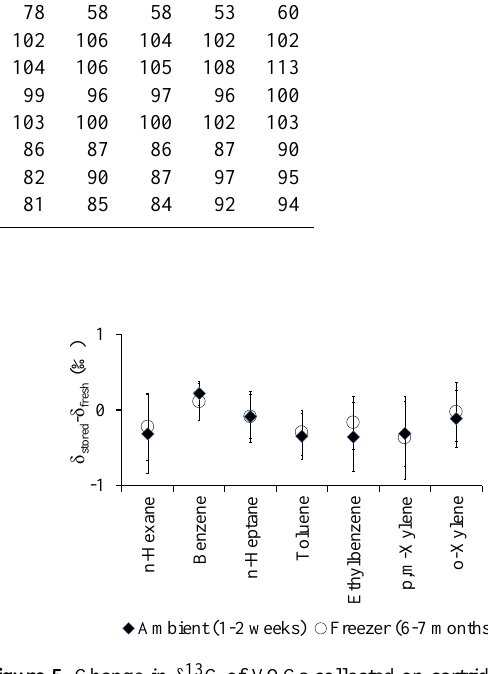
Figure 5. Change in δ 13 C of VOCs collected on cartridges during storage for 1 to 2 weeks at ambient temperatures (diamonds) and 6 to 7 months in a freezer (circles). The differences are given rela- tive to the δ 13 C values of samples analyzed without storage. Both storage tests used the same reference values. Values used are the average of three to four measurements and the error bars show the variability of results for analysis after storage. Masses loaded range from 25 to 75ng. Values were not corrected for